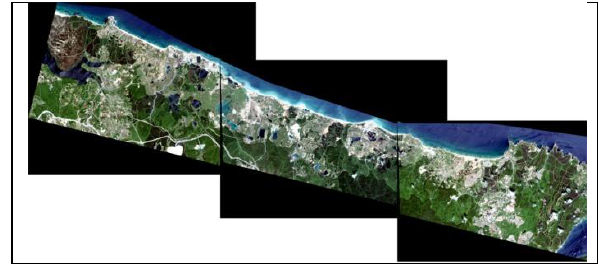
Fig. 2 : location of the three used WorldView-2 models The images of the individual scenes are divided in up to 14 tiles which have been merged together based on the tile-file to simplify the image matching. A rough overlay of the left